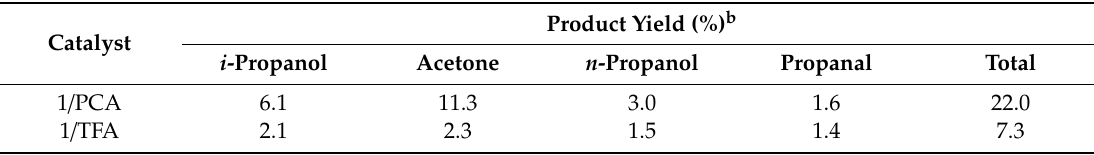
Table 2. Mild oxidation of propane with H 2 O 2 catalyzed by 1 . a.